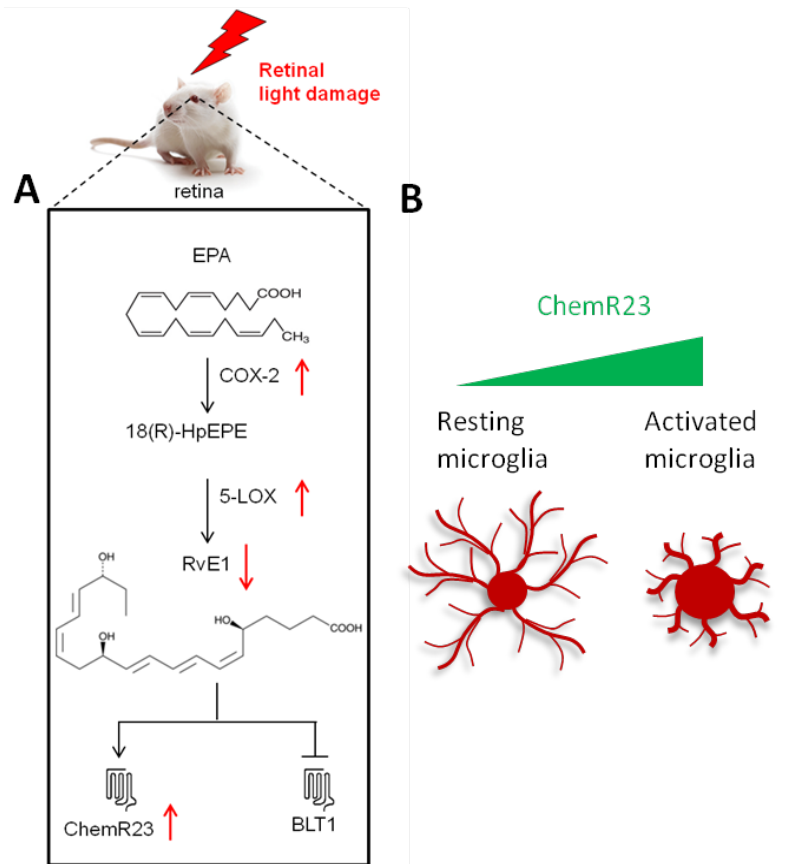
Figure 7. Schematic illustration of the main findings of the study. The scheme summarizes the results obtained from the retinas 7 days after LD (LD + 7rec group). ( A ) Effects of light damage (LD) on RvE1 metabolism and signaling in the rat retinas; the black lines indicate RvE1 metabolism and signaling, while the red arrows indicate the events induced by LD. ( B ) Schematic cartoon illustrating the different expressions observed in retinal resting and activated microglia.